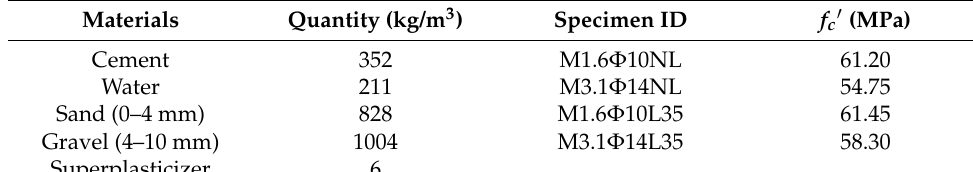
Table 2. Standard concrete mix design and concrete compressive strengths.